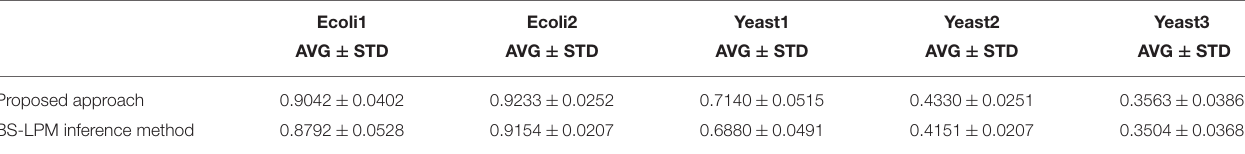
AVG and STD represent the averaged value of the AURPCs and its standard deviation, respectively.